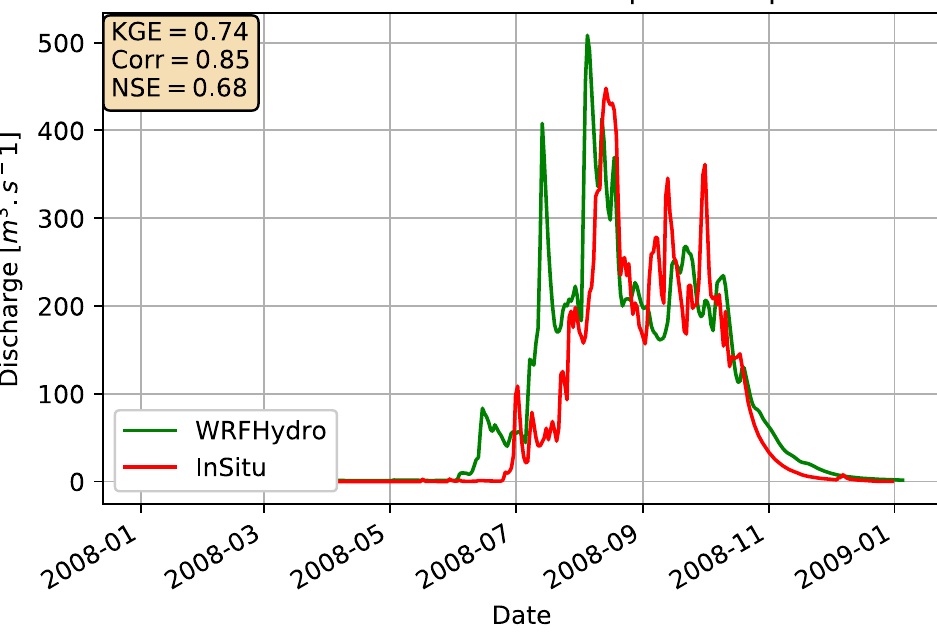
Figure 3. Observed and simulated (uncoupled WRF-Hydro) daily hydrographs at Savè, and catch- ment-averaged daily precipitation derived from WRF-only: ( a ) calibration period 2008; ( b ) valida- tion period 2009–2010.